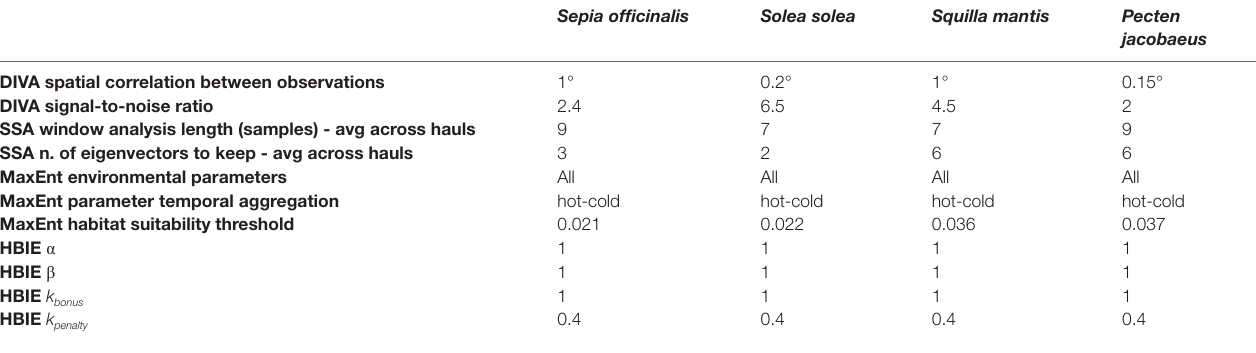
TABLE 2 | Optimal model parameters estimated for the analysed stocks based on the SoleMon